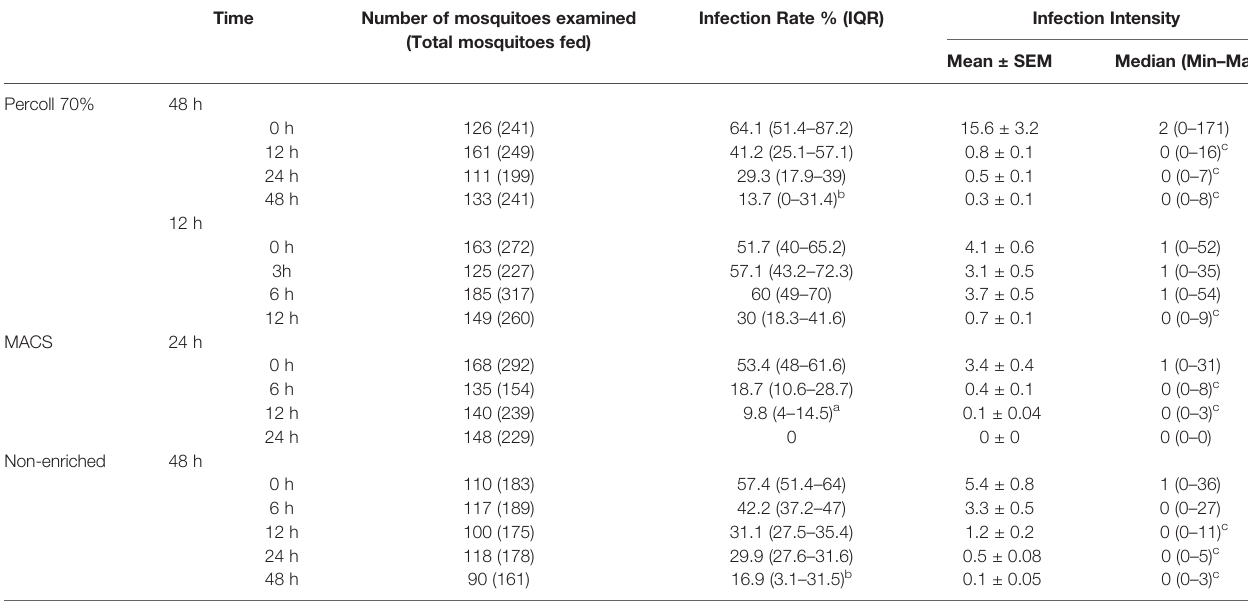
TABLE 1 | Experimental infection in An. Aquasalis by membrane feeding assay (MFA). Time Number of mosquitoes examined (Total mosquitoes